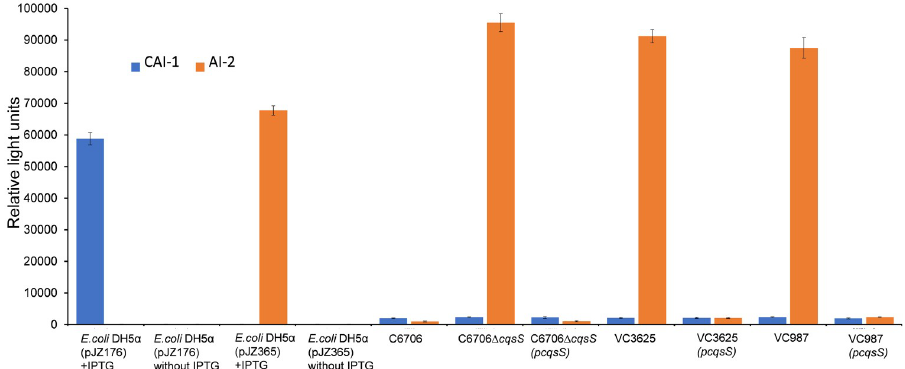
Fig 1. Activity of autoinducers produced by different bacterial strains and their derivatives as assayed using bioluminescence produced by reporter strains for CAI-1 and AI-2 (see text for details). VC3625 and VC987 are environmental V . cholerae O1 strains whereas C6706 is a laboratory strain of V . cholerae O1. Recombinant plasmids pJZ176 and pJZ365 carry CAI-1 and AI-2 synthase genes respectively, whereas pcqsS carries a cloned cqsS gene which encodes the sensor for